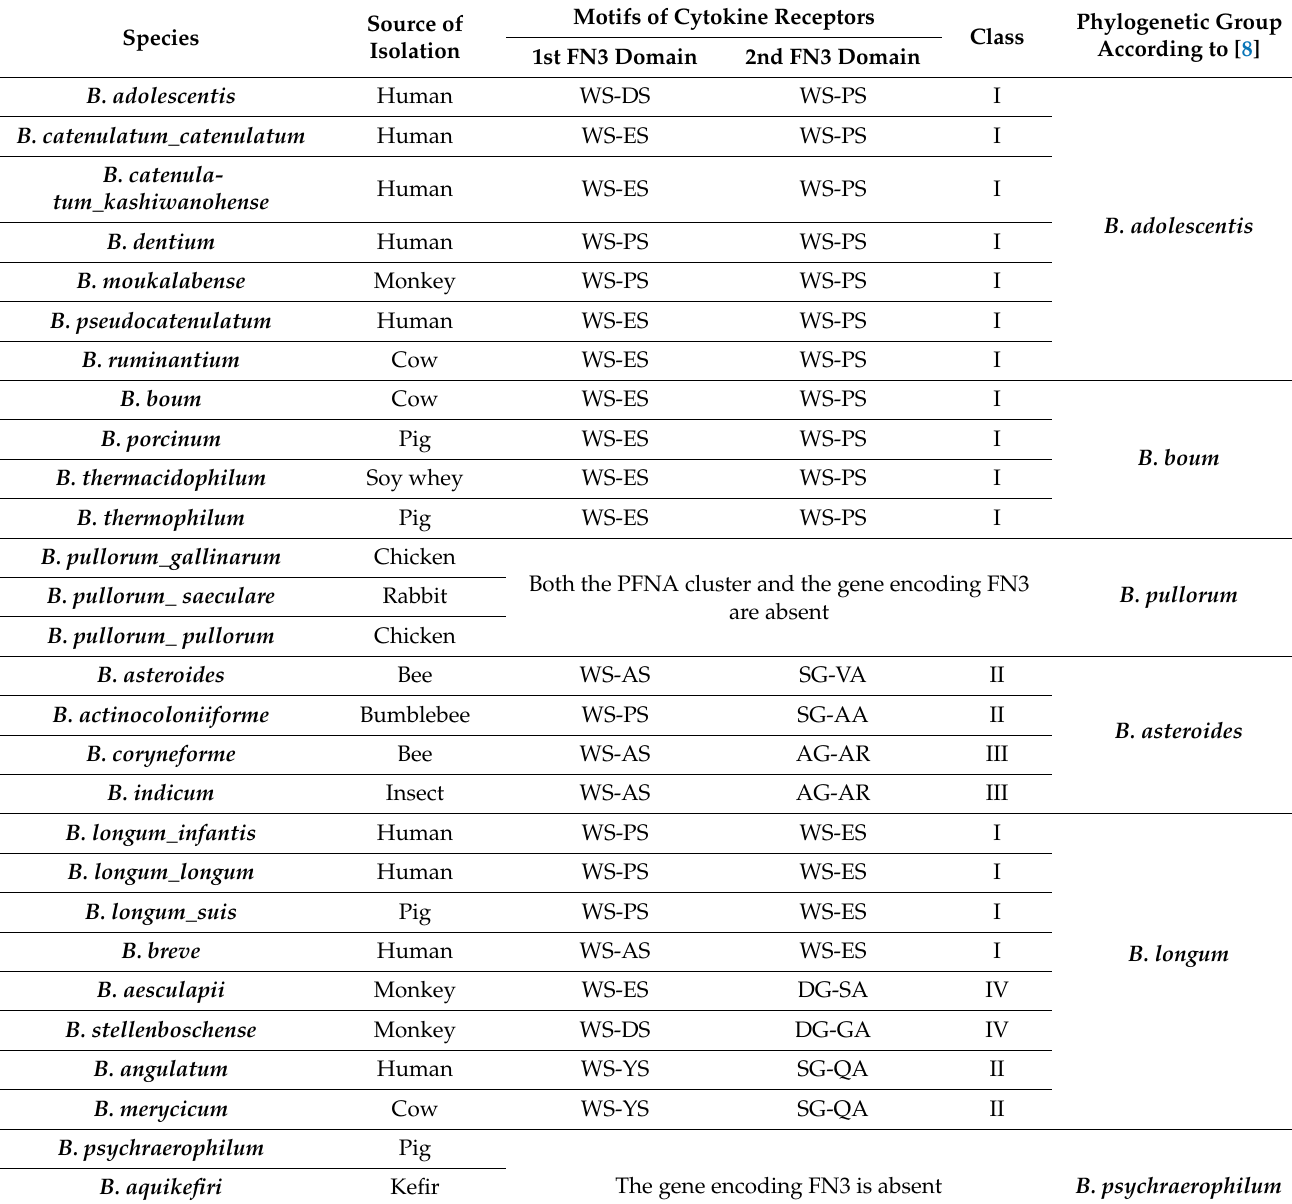
Table 1. Motifs of cytokine receptors found in the fibronectin domains of bifidobacteria belonging to different species and phylogenetic